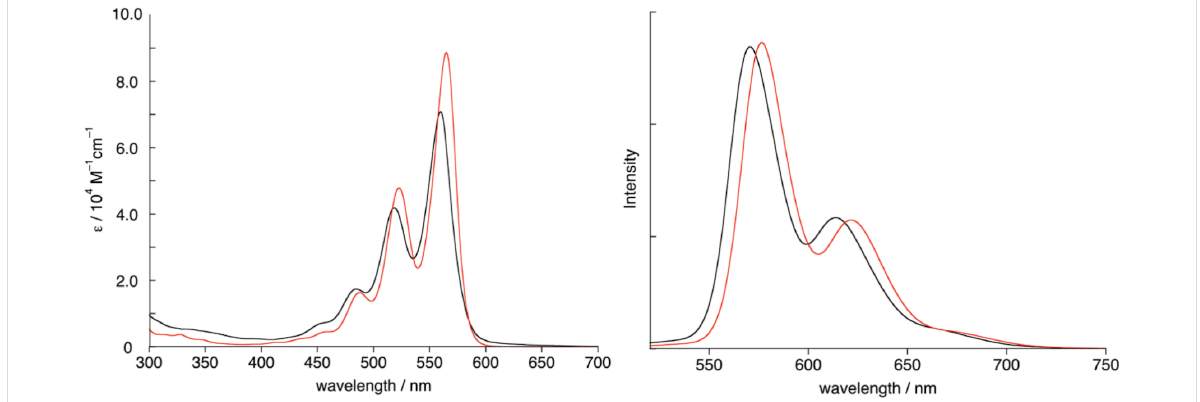
Figure 3: UV–vis absorption and fluorescence spectra of terrylene (black) and TB4 (red) in toluene. λ ex = 489 nm. Fluorescence intensity reflects the absolute fluorescence quantum yields.